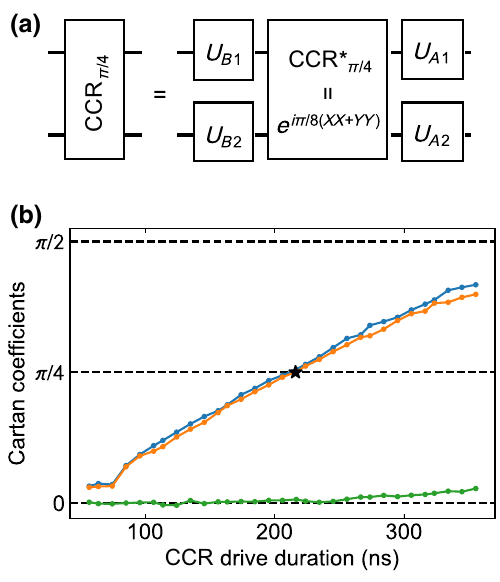
FIG. 2. (a) Desired condition for an entangling gate generated by CCR drive. (b) Approximate Cartan coefficients of entangling gates while the CCR drive duration is